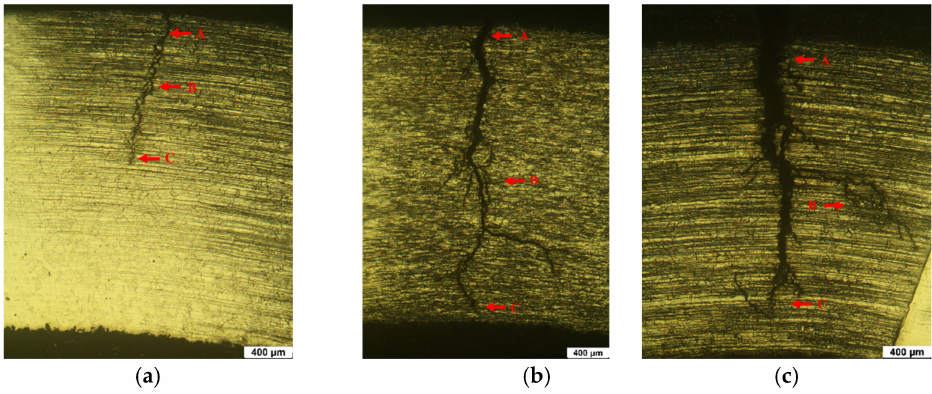
Figure 4. Photographs of the cross section of 304LB after U-bend SCC test (OM, × 50, 155 ◦ C, 42%